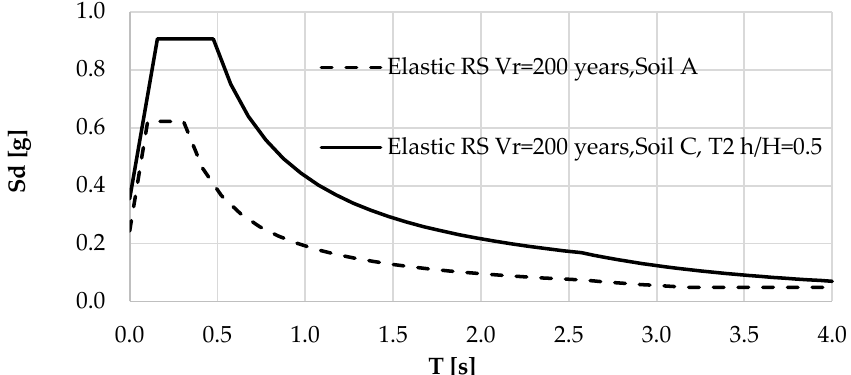
Figure 2. Comparison between elastic response spectrum for soil A and elastic response spectrum for the Terenzo site for ULS, according to Italian the design code.